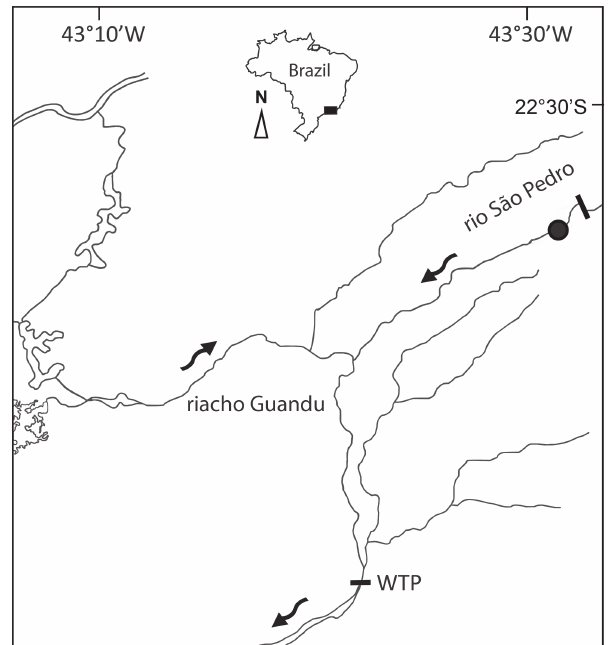
Fig. 1 . Map of the rio Guandu basin, with indication of the studied reach in riacho São Pedro. Solid dash = small substation of CEDAE (Water and Sewer Treatment Works of Rio de Janeiro State). WTP: Water Treatment